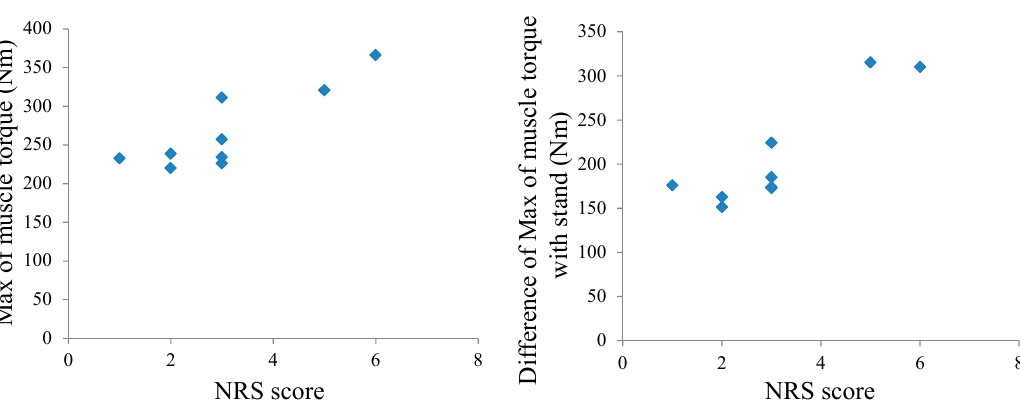
Figure A2. Scatter diagram of numerical rating scale (NRS) score with maximum of muscle torque and difference of maximum of muscle torque with stand.